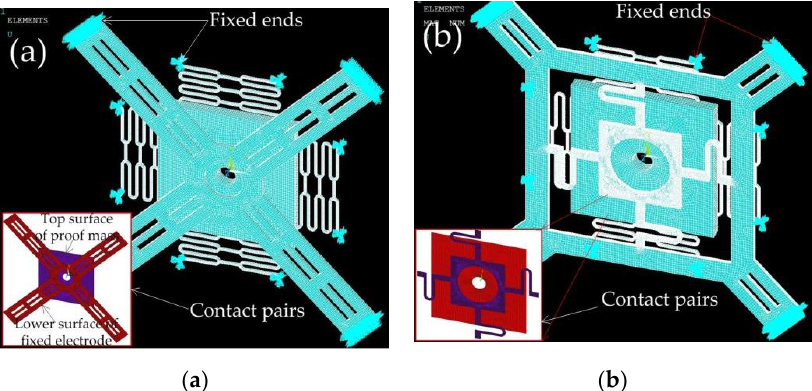
Figure 6. Finite element models of inertial switch with fixed electrode of ( a ) simply supported beam and ( b ) suspension spring.